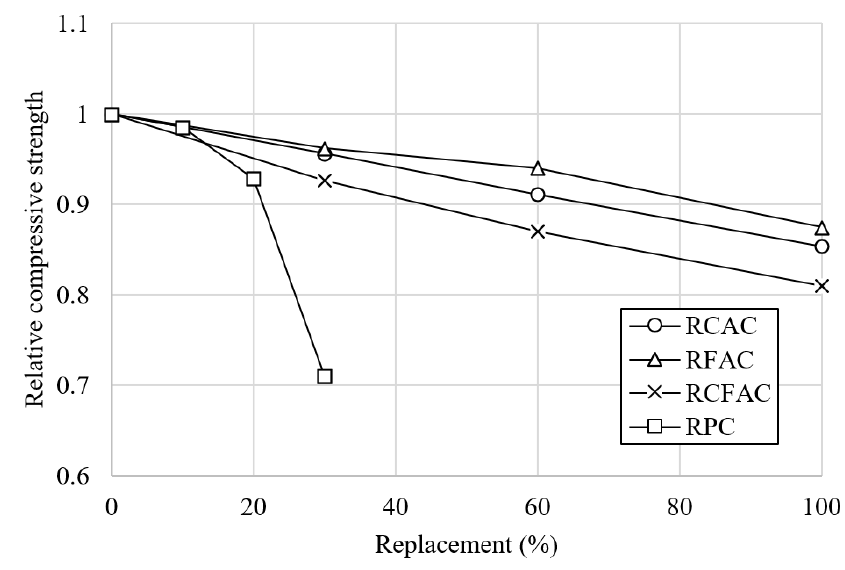
Figure 5. Relative compressive strength of various concretes by replacement ratio.